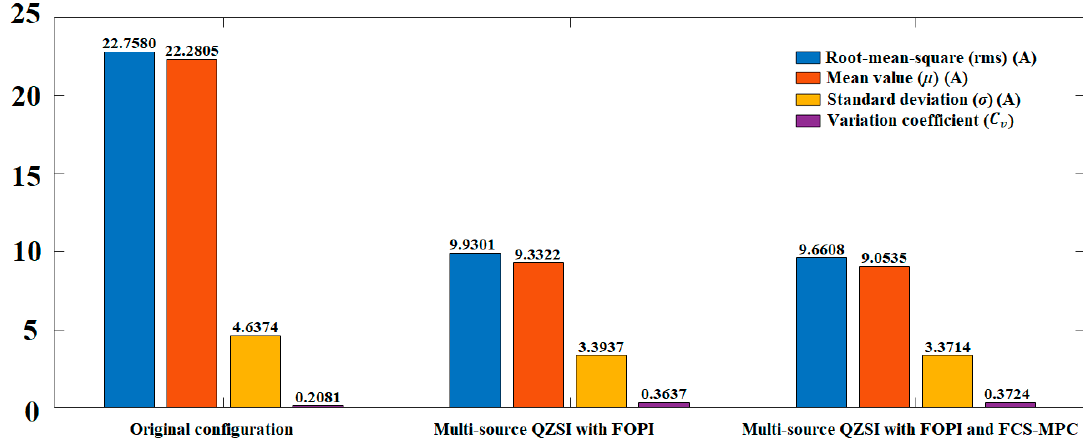
Figure 16. Performance comparison using aging index factors.